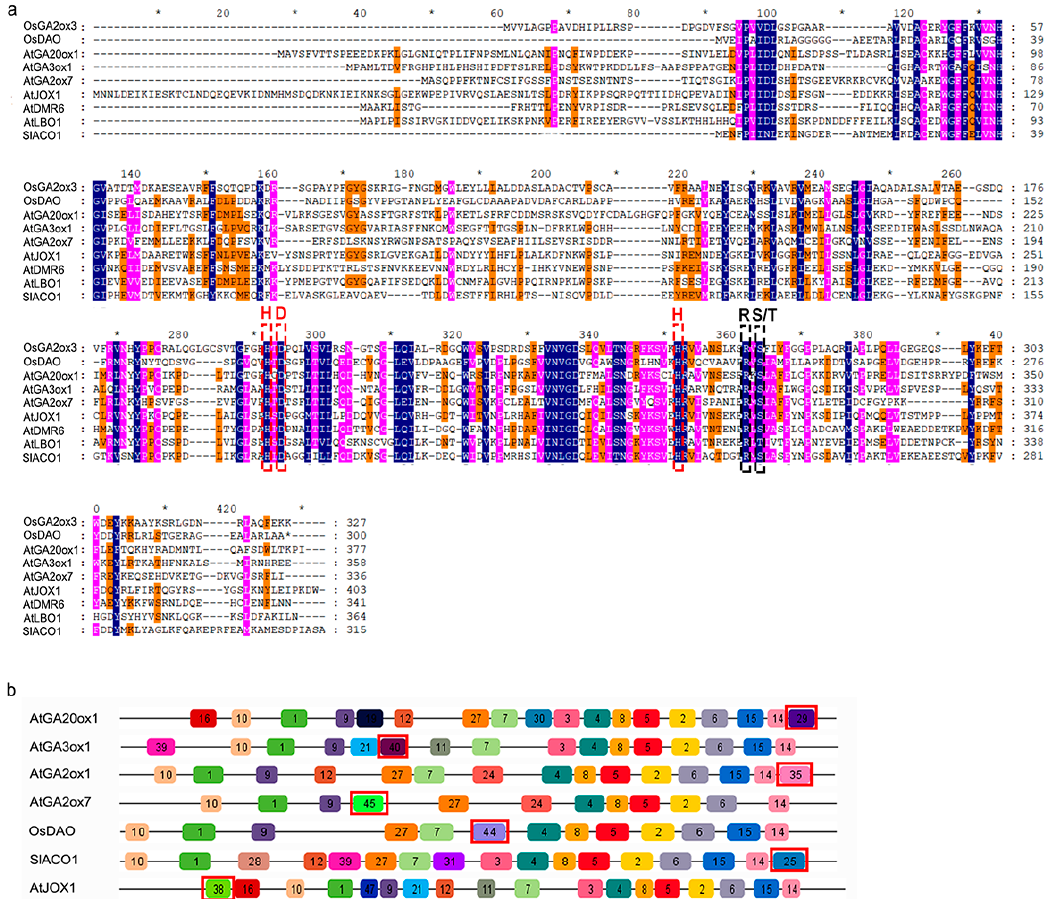
Figure 3. Sequence alignment and conserved motif analysis of functionally characterized hormone biosynthetic and metabolism 2OGD proteins. ( a ) Sequence alignment of functionally characterized hormone biosynthetic and metabolism 2OGD proteins in Arabidopsis , rice, tomato. The putative His-X-Asp-(X) n -His (HxD ... H) and Arg-X-Ser / Thr (RxS / T) motif locations are highlighted in red and black dotted boxes, respectively. ( b ) The motif composition of functionally characterized hormone biosynthetic and metabolism 2OGD proteins. The motif enclosed by red boxes is specific motifs in each